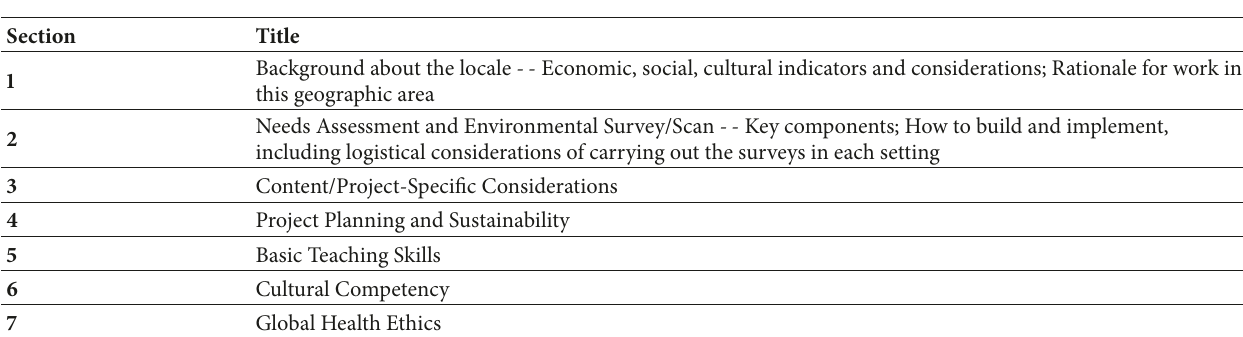
Table 2: Curriculum